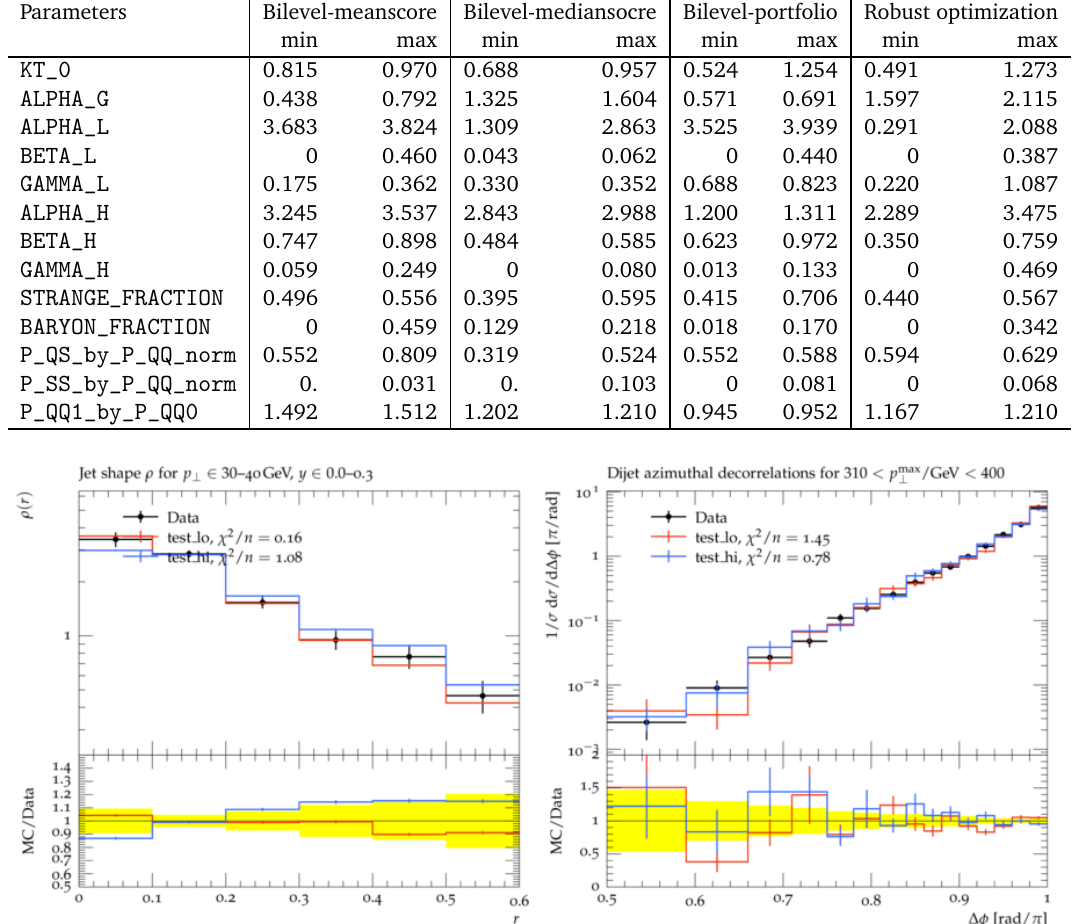
Figure 7: Two exemplary distributions with uncertainty band included. The upper band is in blue and lower band in red. The bottom panel shows the ratio of MC pre- dictions over the data where the yellow band shows the uncertainties associated with the data. Left: jet shape ρ as a function of the distance to the jet axis r ; Right: the differential cross section of dijet events as a function of the azimuth angle differences between the two jets ∆ φ